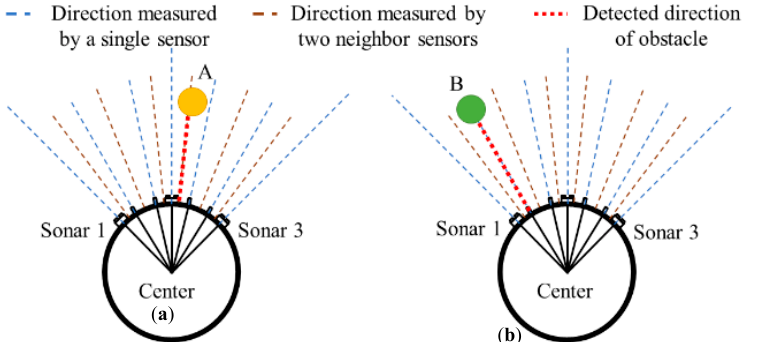
Figure 4. The scenarios of obstacle detection. The ray of each sensor is presented as a dashed line. As the rays intersect with an obstacle, the nearest intersection point is retained. ( a ) An obstacle is in front of the robot. Sonar 2 detects an obstacle with distance less than 150 cm, the robot knows the obstacle is located in front of the robot with azimuth angle 0°. ( b ) Both Sonar 2 and IR 3 detect the obstacle, and the obstacle’s direction will be 6 °, which is between Sonar 2 and IR 3. The distance of the obstacle is the average of the data received from the two sensors.